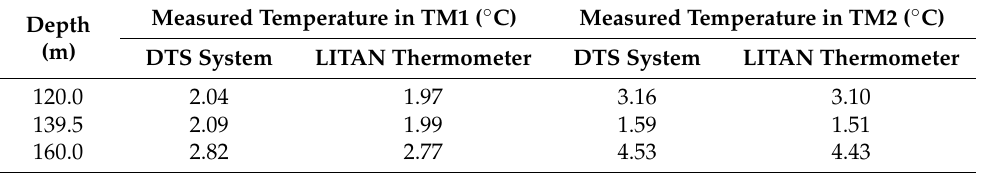
Table 1. Comparative analysis of temperature measurements in TM1 and TM2.